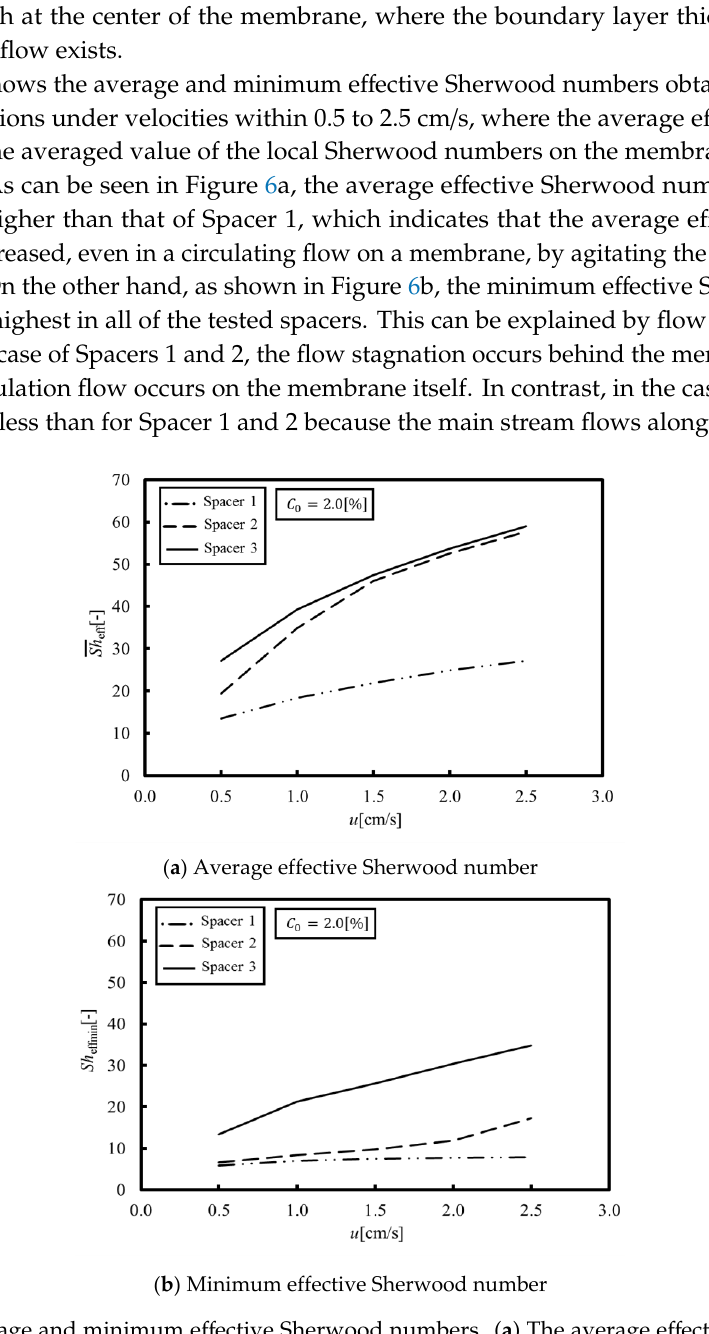
Figure 6. Average and minimum effective Sherwood numbers. ( a ) The average effective Sherwood numbers of Spacers 2 and 3 are much higher than that of Spacer 1; ( b ) The minimum effective Sherwood number of Spacer 3 is the highest in all of the tested spacers.